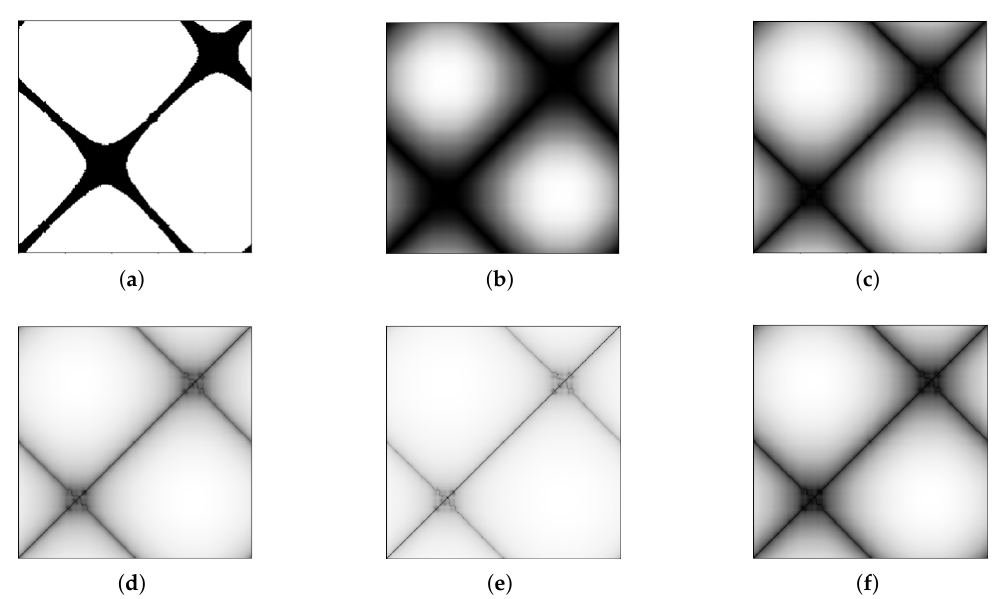
Figure 5. RP, SRP, and ASRP are visualized by heat maps (where ( b – e ) are the different effects of different hyper-parameter choices corresponding to SRP). ( a ) RP. ( b ) SRP ( λ = 1). ( c ) SRP ( λ = 0.6). ( d ) SRP ( λ = 0.2). ( e ) SRP ( λ = 0.1). ( f )